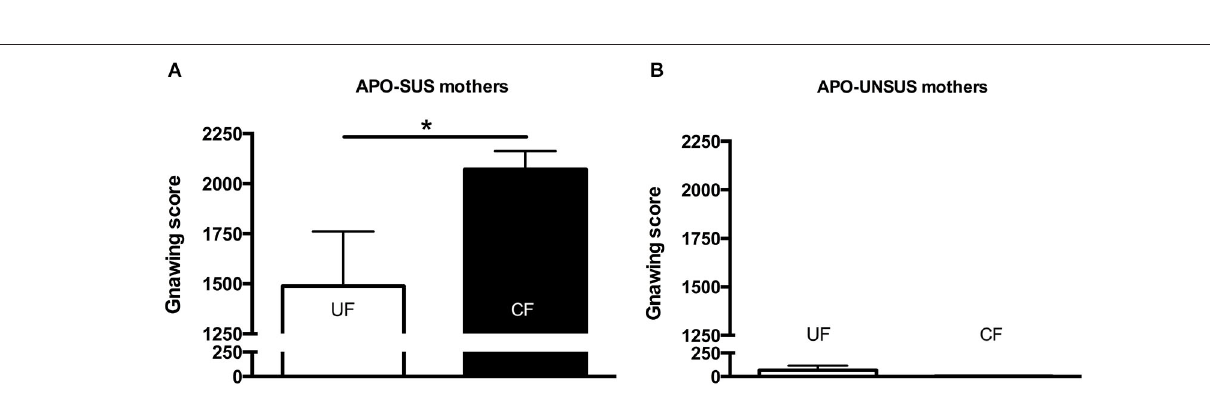
FIGURE 5 | Apomorphine-induced gnawing of APO-SUS (A) and APO-UNSUS (B) mothers after fostering their own pups (white bars) or fostering pups from their phenotypic counterpart (black bars). * p <